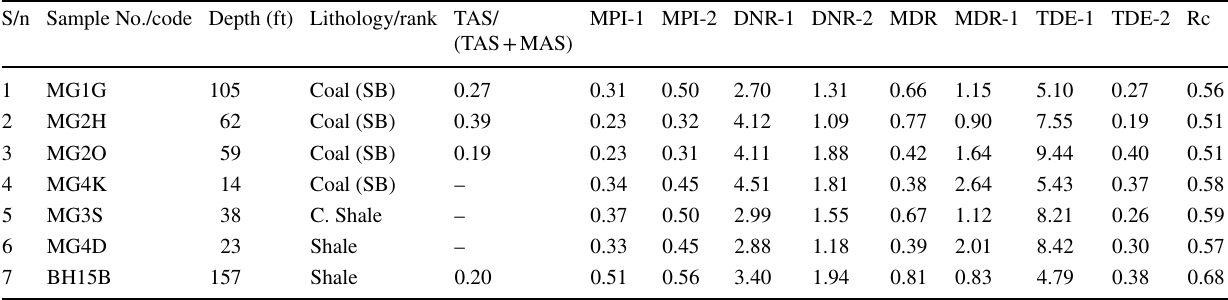
Table 8 Selected Aromatic biomarker maturity indices of coal and shale sample of Maiganga, Gombe Formation